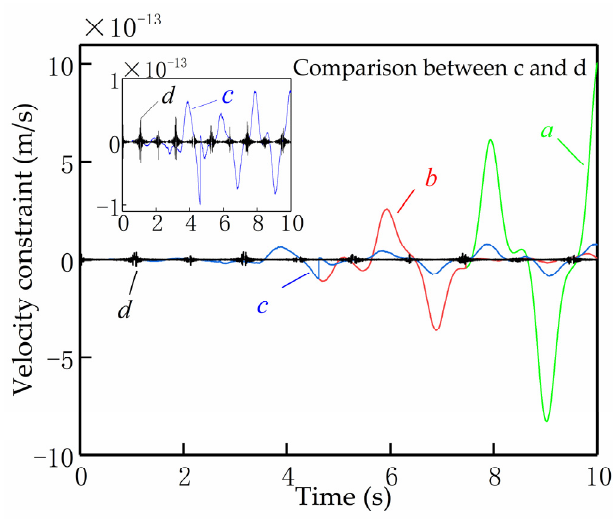
Figure 6. The violation of velocity constraint in the x-direction.